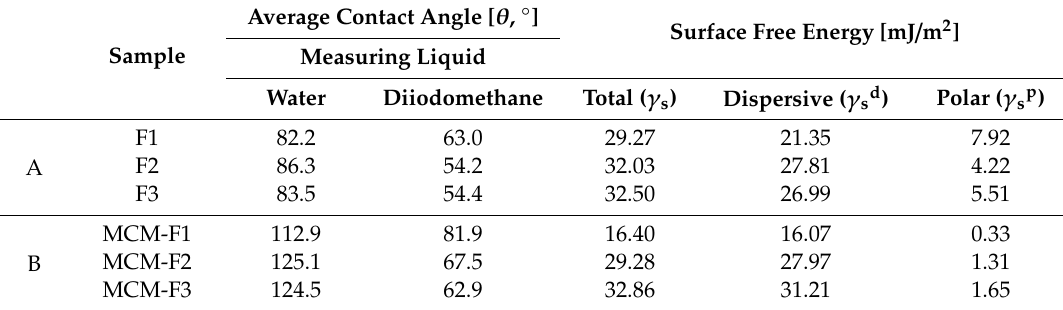
Table 3. Average contact angle and surface free energy ( γ s ) with its dispersive ( γ sd ) and polar ( γ sp ) components of solid films of F1, F2, F3 ( A ), and MCM-F1, MCM-F2, MCM-F3 ( B ).